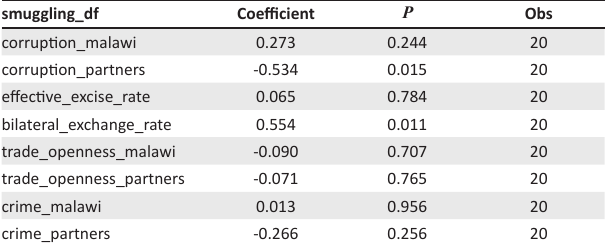
TABLE 6: Correlation between Smuggling (DF) and all other established causes of cigarette smuggling.